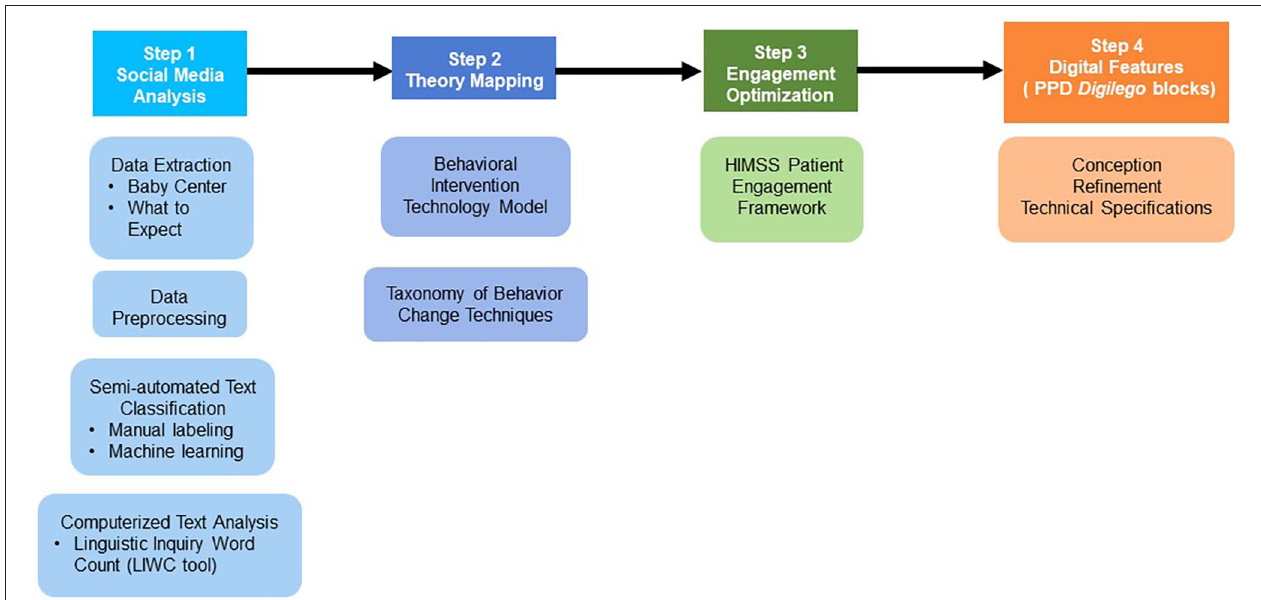
FIGURE 1 | Digilego -powered translation: bridging social media analysis to digital health